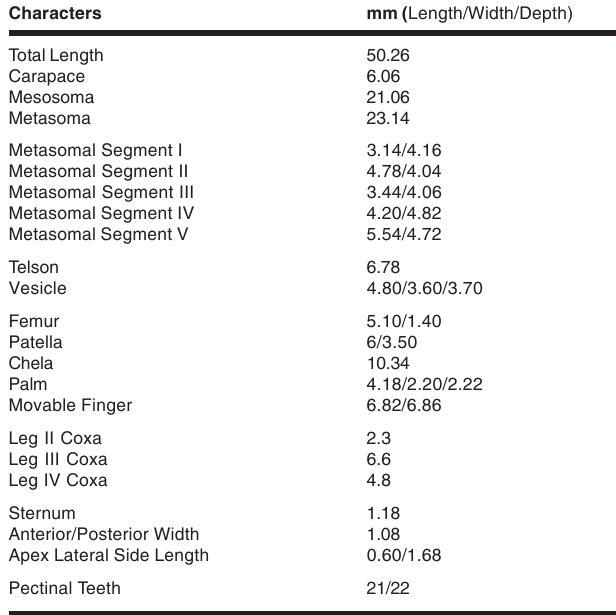
Table 1. Morphometry of the captive adult female Hottentotta pachyurus from 21 February 2007 Characters mm (